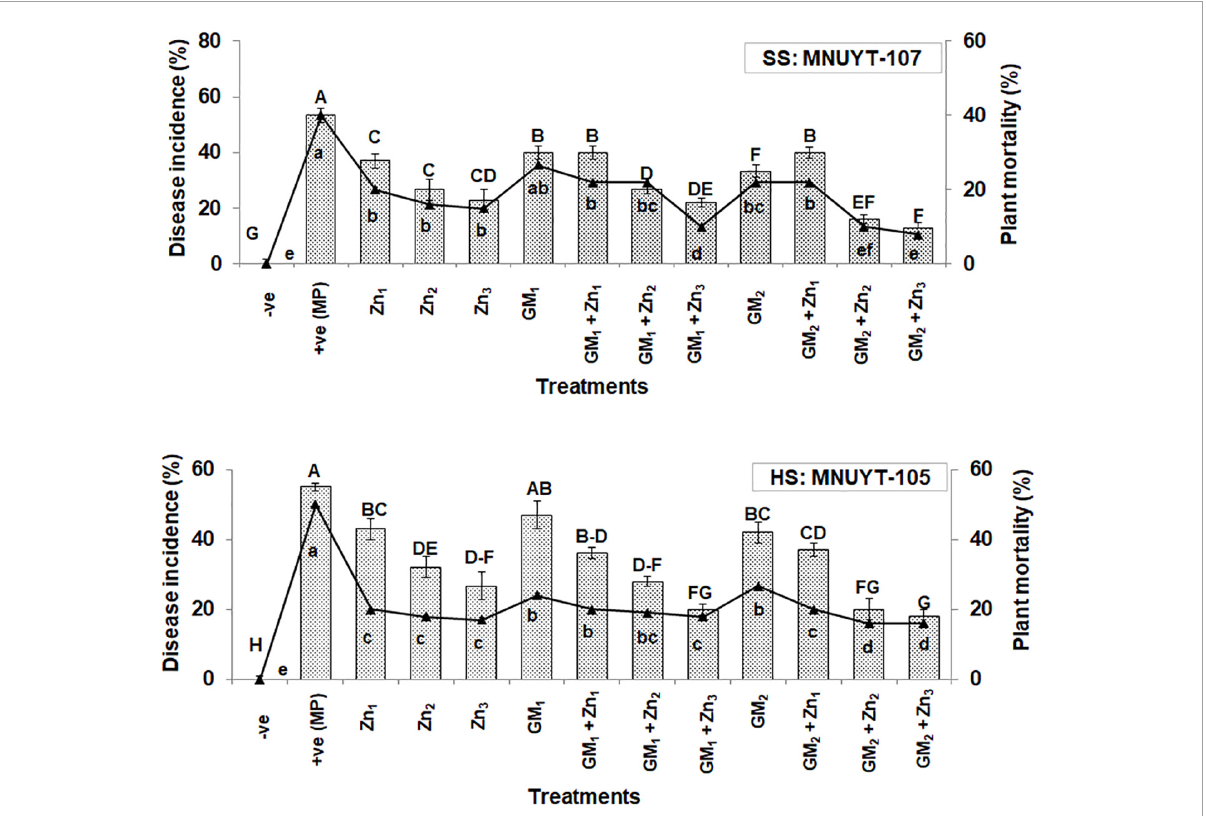
FIGURE1 Effect of soil application with zinc (Zn) and green manure (GM) on charcoal rot disease incidence (%) and plant mortality (%) in susceptible (SS: MNUYT-107) and highly susceptible (HS: MNUYT-105) genotypes of mungbean after 70 days of sowing. –ve control (without pathogen, Zn or GM); +ve control [ M. phaseolina (MP)]; Zn 1 (1.25 mg/kg); Zn 2 (2.44 mg/kg); Zn 3 (5 mg/kg); GM 1 (1%); and GM 2 (2%). Vertical bars show standard errors of means of three replicates. Means with the same letters are not significantly different at p < 0.05 according to Fisher’s least significant difference (LSD)